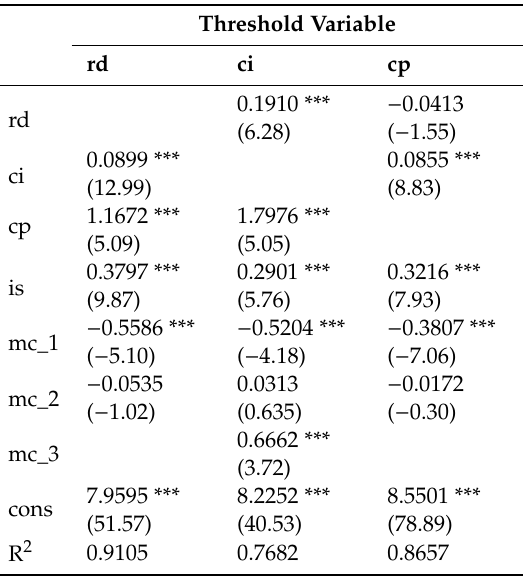
Table 11. Threshold model regression results for stock market value and carbon